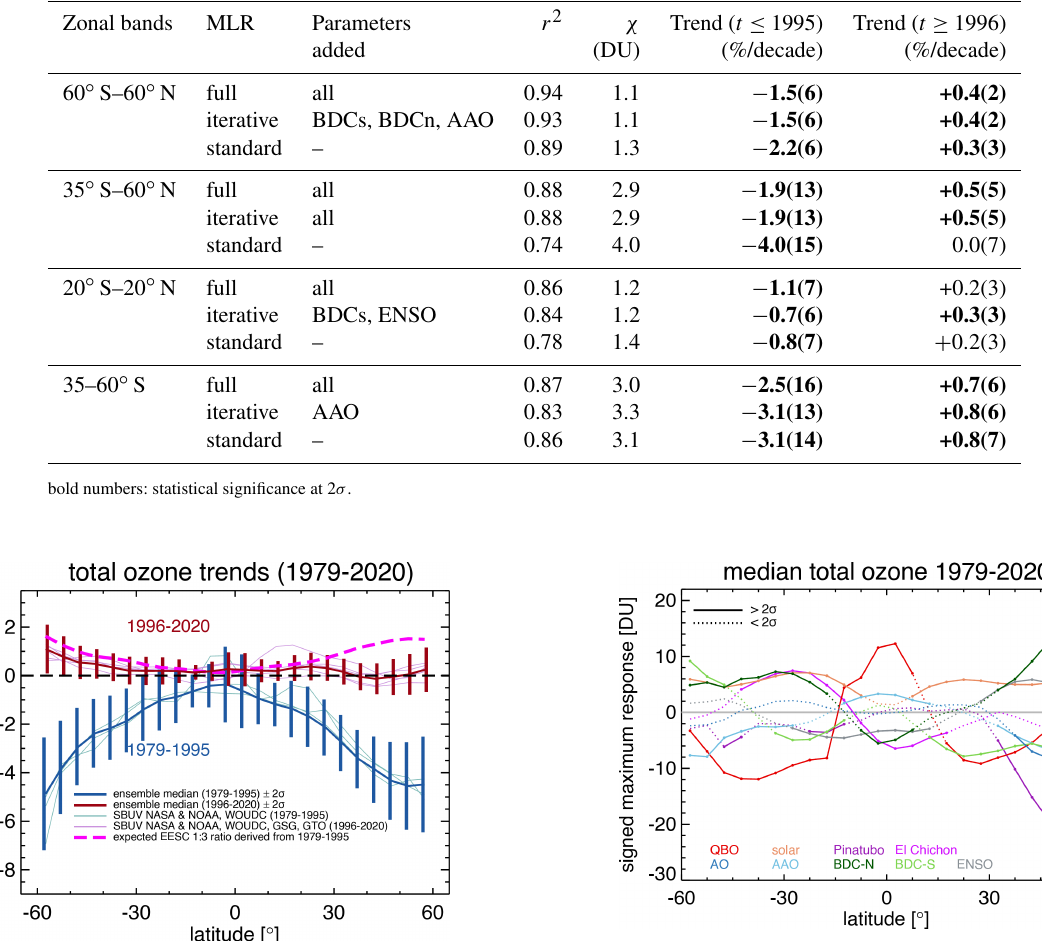
lies in the NH winter and spring to SH total ozone was